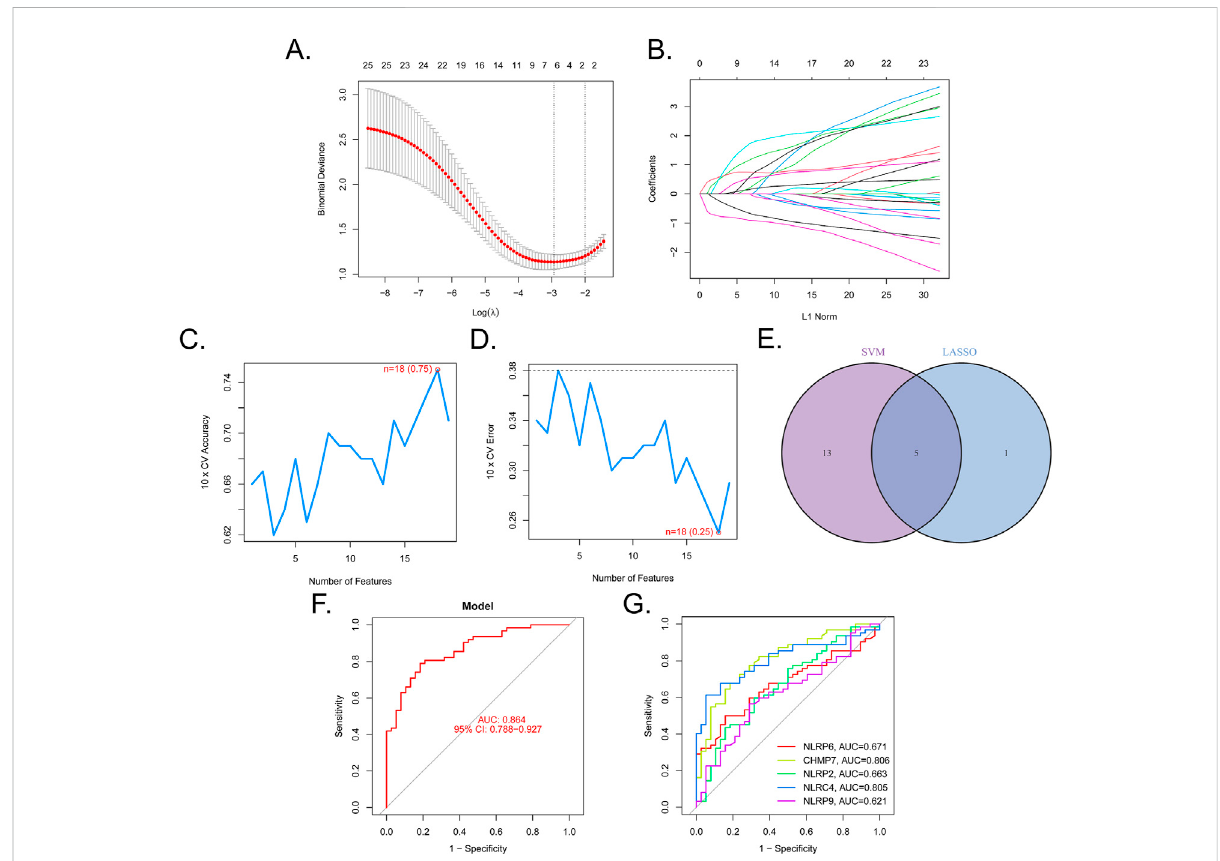
FIGURE 3 Five DE-PRGs were identi fi ed as biomarkers for BPD. (A,B) LASSO algorithm with penalty parameter tuning conducted by 10-fold cross- validation was used to select six BPD-related markers. (C,D) SVM-RFE algorithm to screen the 25 DE-PRGs to identify the optimal combination of marker genes. In total, 18 genes were identi fi ed as the optimal marker genes. (E) Marker genes obtained from the LASSO and SVM-RFE models. (F) Logistic regression model to determine the AUC of BPD samples. (G) ROC curves for the fi ve